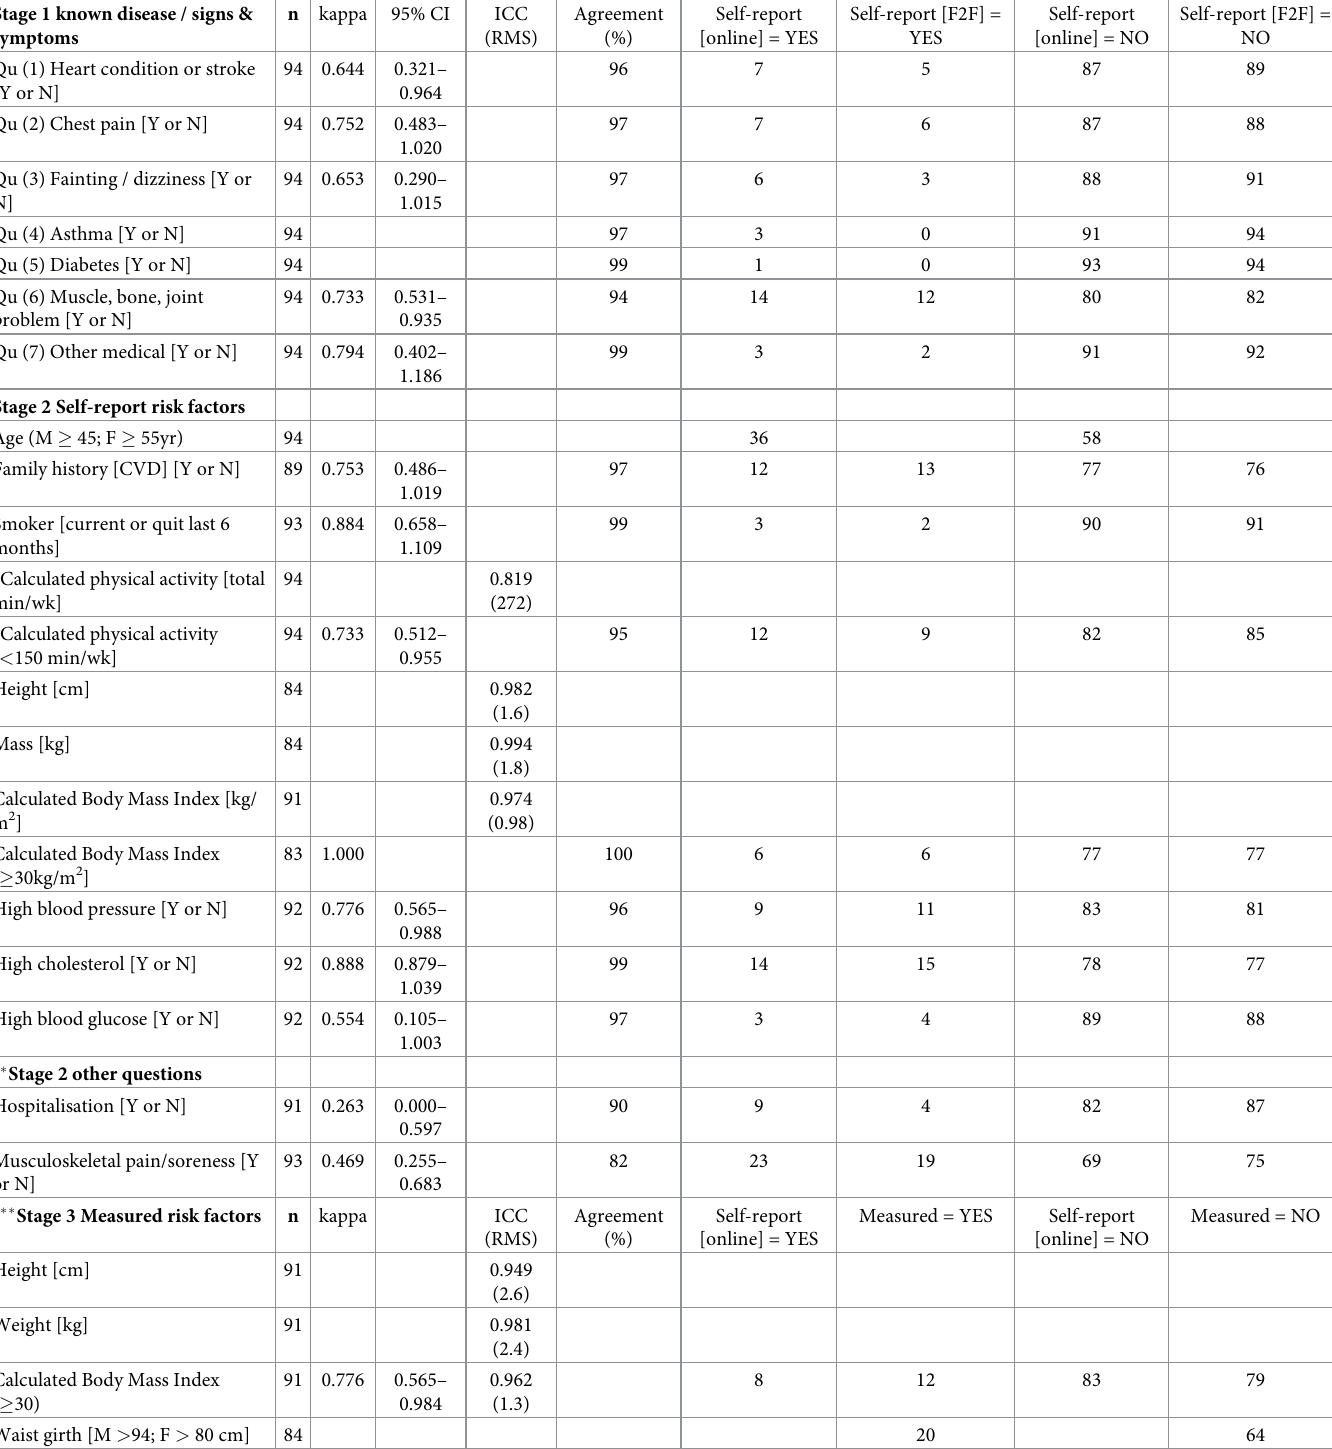
Table 2. Results of the comparisons between the online and F2F responses and other measured variables. Stages 1 and 2 are online versus F2F responses. (cid:3) Total weighted physical activity = walking + moderate + (2x vigorous minutes). (cid:3)(cid:3) No pregnancies were reported in either mode. (cid:3)(cid:3)(cid:3) Stage 3 relates to measured health risk fac- tors versus online responses (except waist). Y = Yes; N = No; CVD = cardiovascular disease; SBP = systolic blood pressure; DBP = diastolic blood